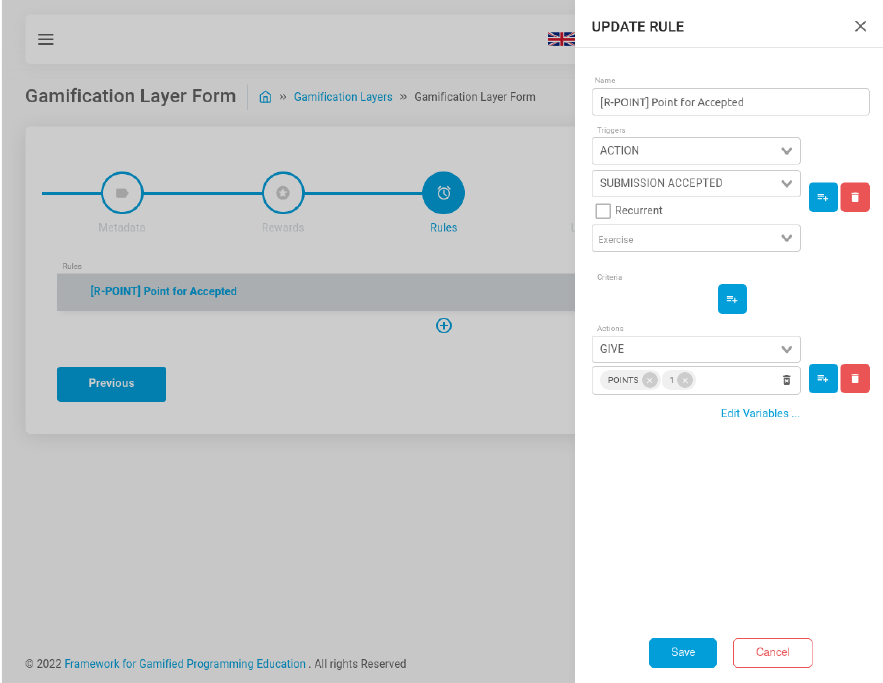
Figure 3. Screenshot of FGPE AuthorKit while editing a rule on the gamification layer